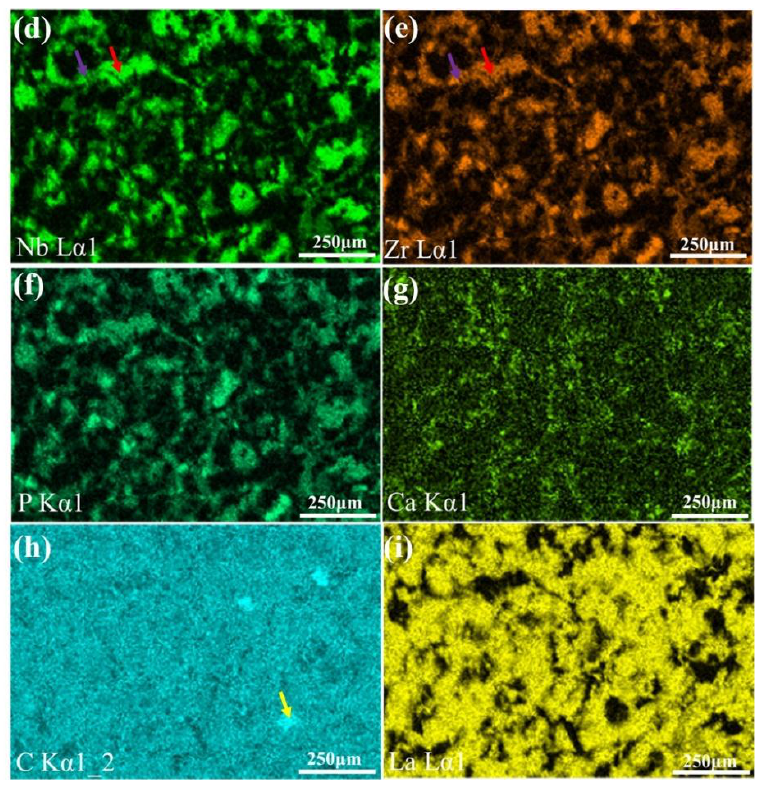
Figure 6. ( a ) SEM micrographs of the 0.5-GNFs nanocomposite sintered at 1000 °C. The corresponding mapping scanning results of EPMA: ( b ) Ti; ( c ) Ta; ( d ) Nb; ( e ) Zr; ( f ) P; ( g ) Ca; ( h ) C; and ( i )